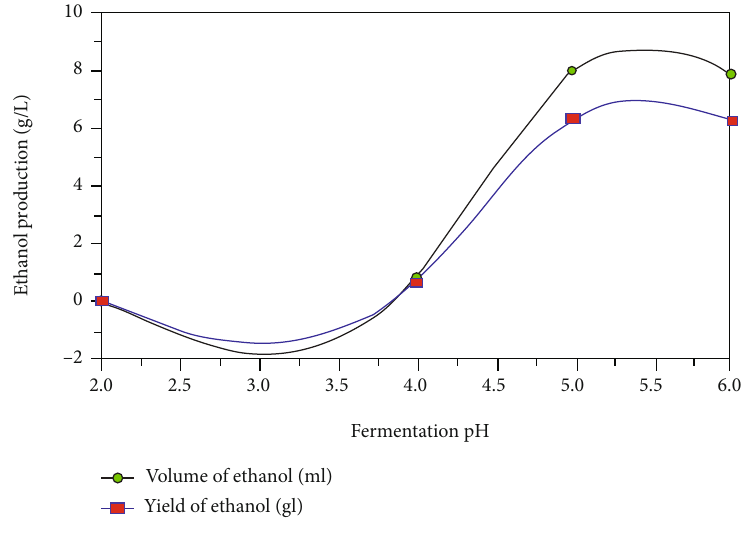
Figure 5: The e ff ect of pH on ethanol production